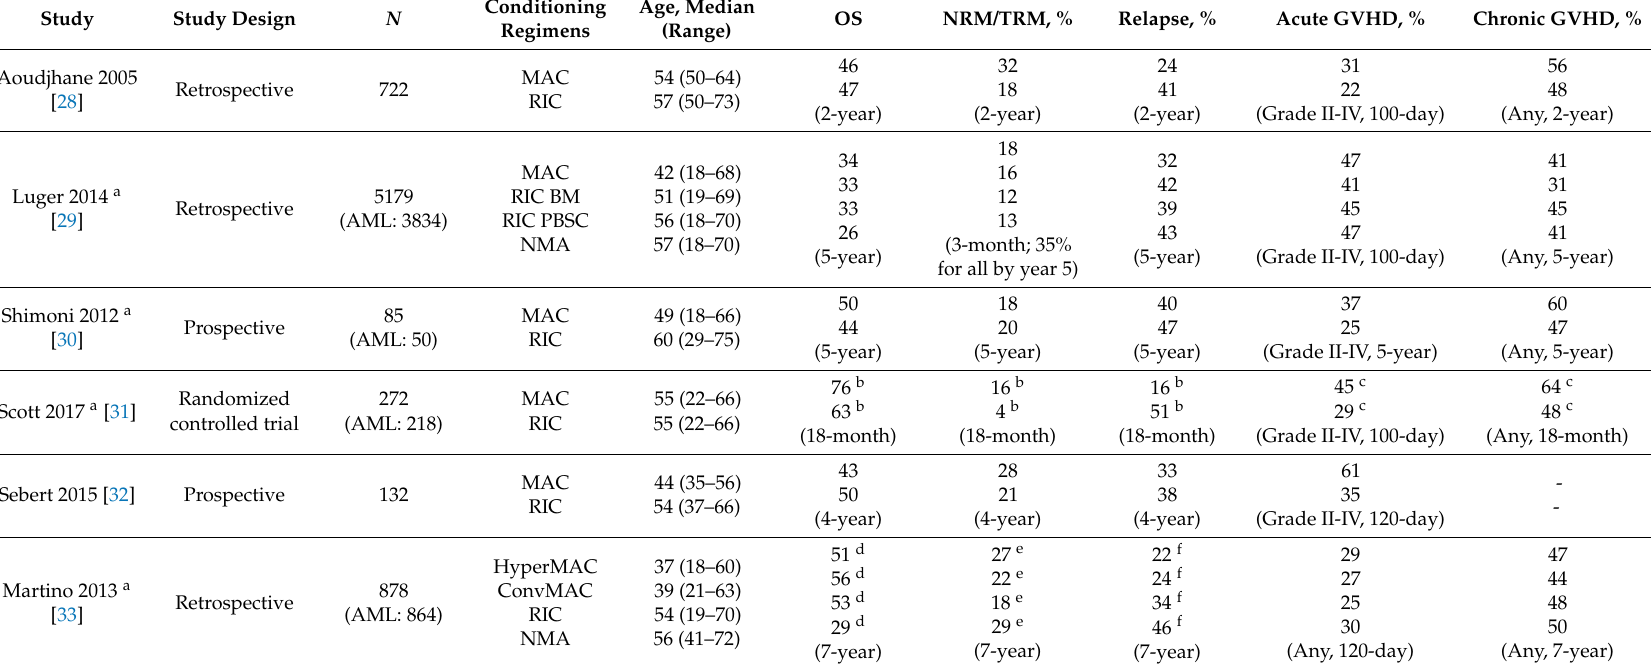
Table 1. Examples of studies that compared the various conditioning regimens and included some patients aged 60 and